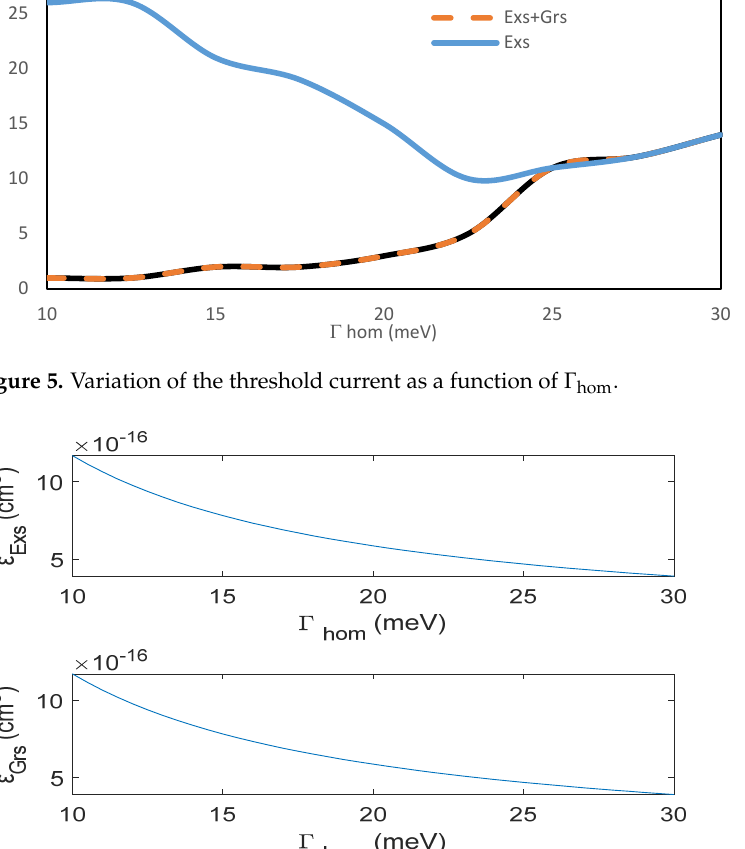
Figure 6. Variation of gain compression factor as function of the Γ hom for I rf = 40 mA.